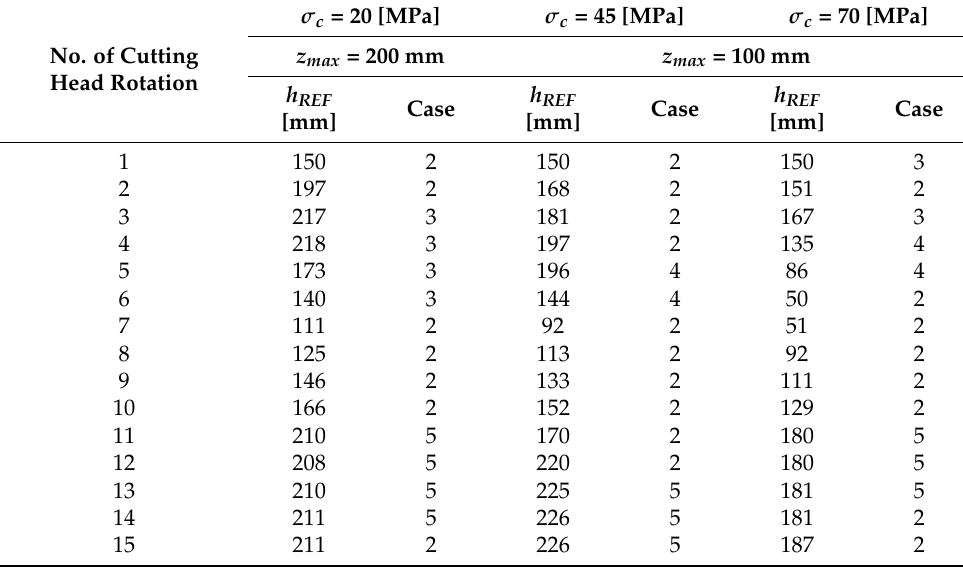
Table 1. Set values of the cut height determined by the setting system and dynamic load cases of cutting heads drive for various uniaxial compressive strengths of mined rocks in subsequent rotations of the cutting